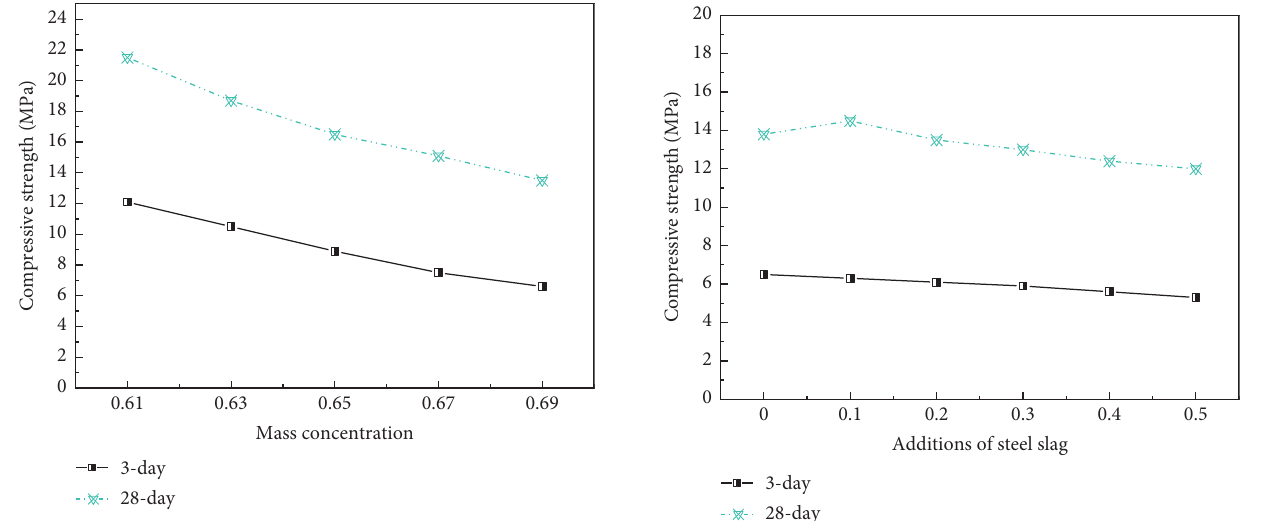
Figure 9: The compressive strength of the waste sediment-based grouting material with different mass concentrations of solid components.